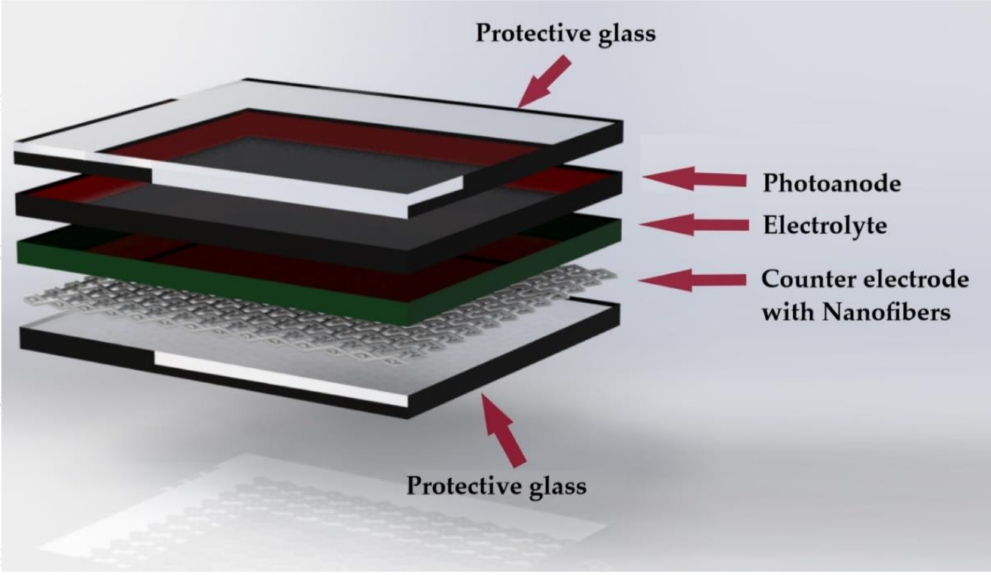
Figure 4. Counter electrode with electrospun nanofibers in a